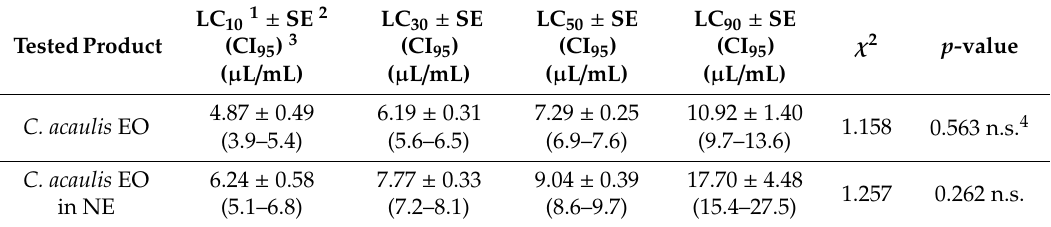
Table 2. Larvicidal activity of Carlina acaulis essential oil (EO) and its 6% nanoemulsion (NE) against 1st instar larvae of Lobesia botrana